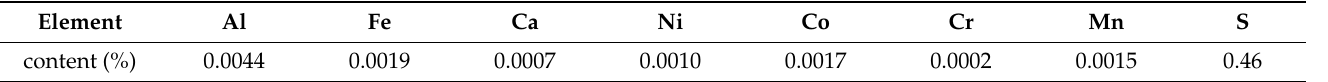
Table 5. The total element analysis of MgO after calcination of 4MgCO 3 · Mg(OH) 2 · 4H 2